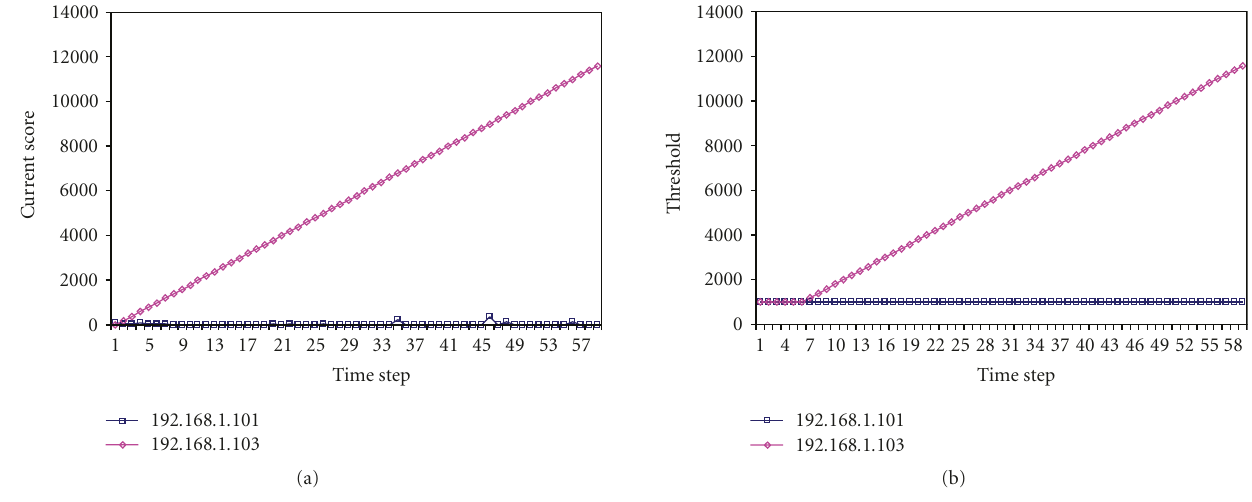
Figure 3: Slammer simulation (with a propagation delay of 1 second).